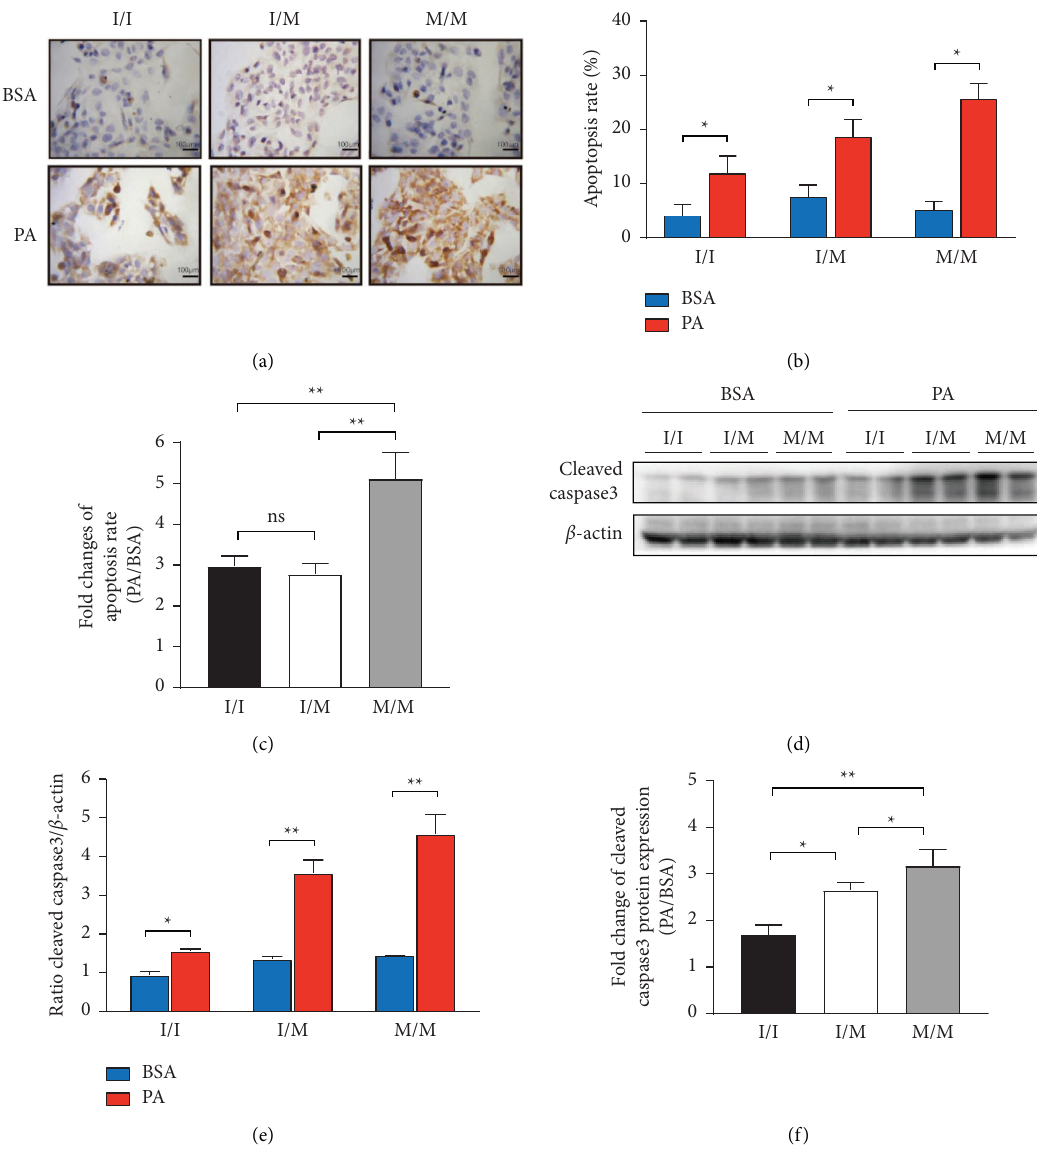
Figure 2: Apoptosis in HepG2 cells and cleaved-caspase-3 expressing. The three genotypic HepG2 cells were treated with 0.3mM PA for 24h. (a) The visualized TUNEL staining assay using a research-grade inverted microscope at 400x magnification. The scale bar in each image represents 100 µ m. (b) The percentage of TUNEL-positive cells. (c) Fold change (PA/BSA) of (b). (d) The protein level of cleaved-caspase-3 detected by western blot. (e) The quantitative analysis of gray value based (d) performed using image-pro plus software. (f) Fold change (PA/ BSA) of (e). Biological replicates ( N � 3) were performed per group. Quantitative data are presented as the mean ± SD ( N � 3 independent experiments). ∗ P < 0 . 05; ∗∗ P < 0 .